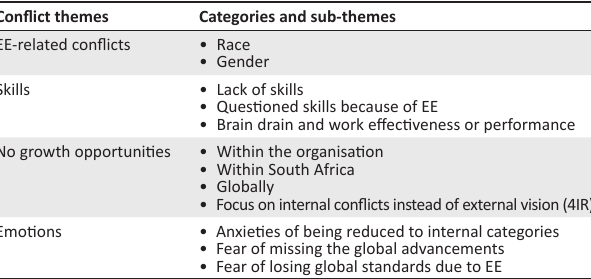
TABLE 1: Conflict